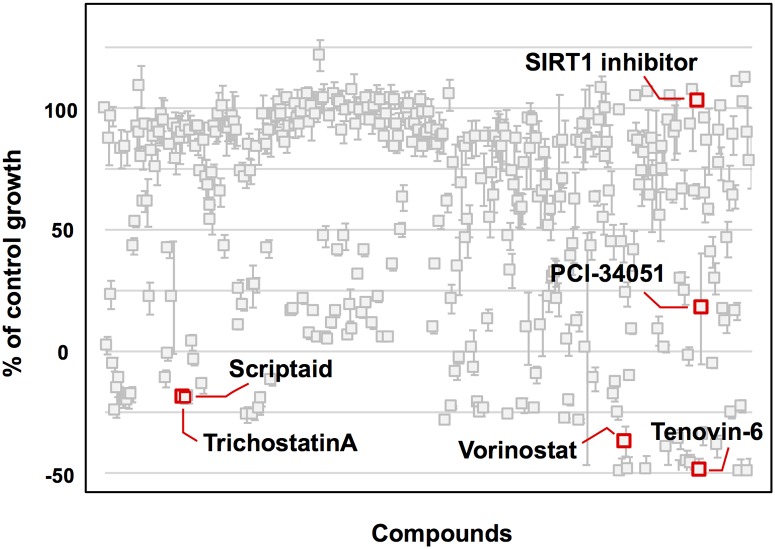
The result of drug screening (SCAD inhibitor kits I-IV).The y-axis represents cell survival (%). Each point represents the result for each compound. HDAC inhibitors are shown in red and labeled with the name of the compounds. The data consists of 4 technical replicates and the values are shown as the mean value ± standard error of the mean.